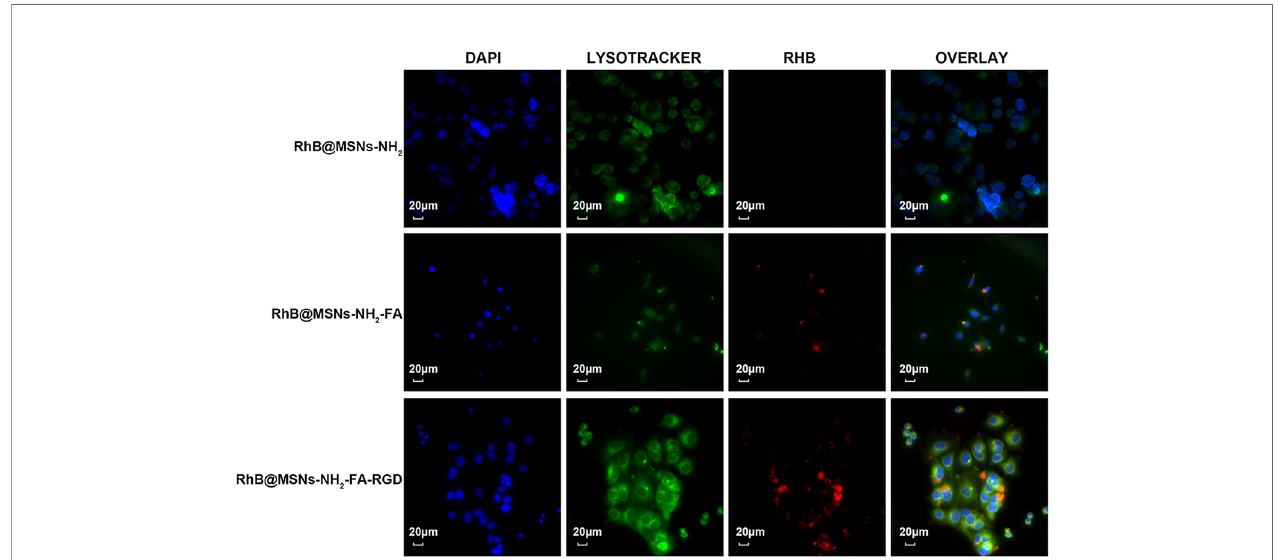
FIGURE 9 | Fluorescence microscopy images of MCF-7 cells incubation with RhB@MSNs-NH 2 , RhB@MSNs-NH 2 -FA, and RhB@MSNs-NH 2 -FA-RGD for 4 h. Blue fl uorescence fi eld: nucleus; green fl uorescence fi eld: cytoplasm; red fl uorescence fi eld: a dye used to label nanocarriers. Scale bar: 20 m